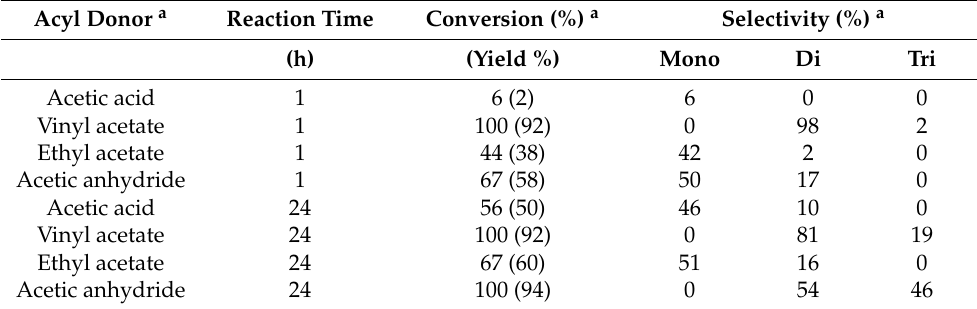
Table 1. Acetins production under batch